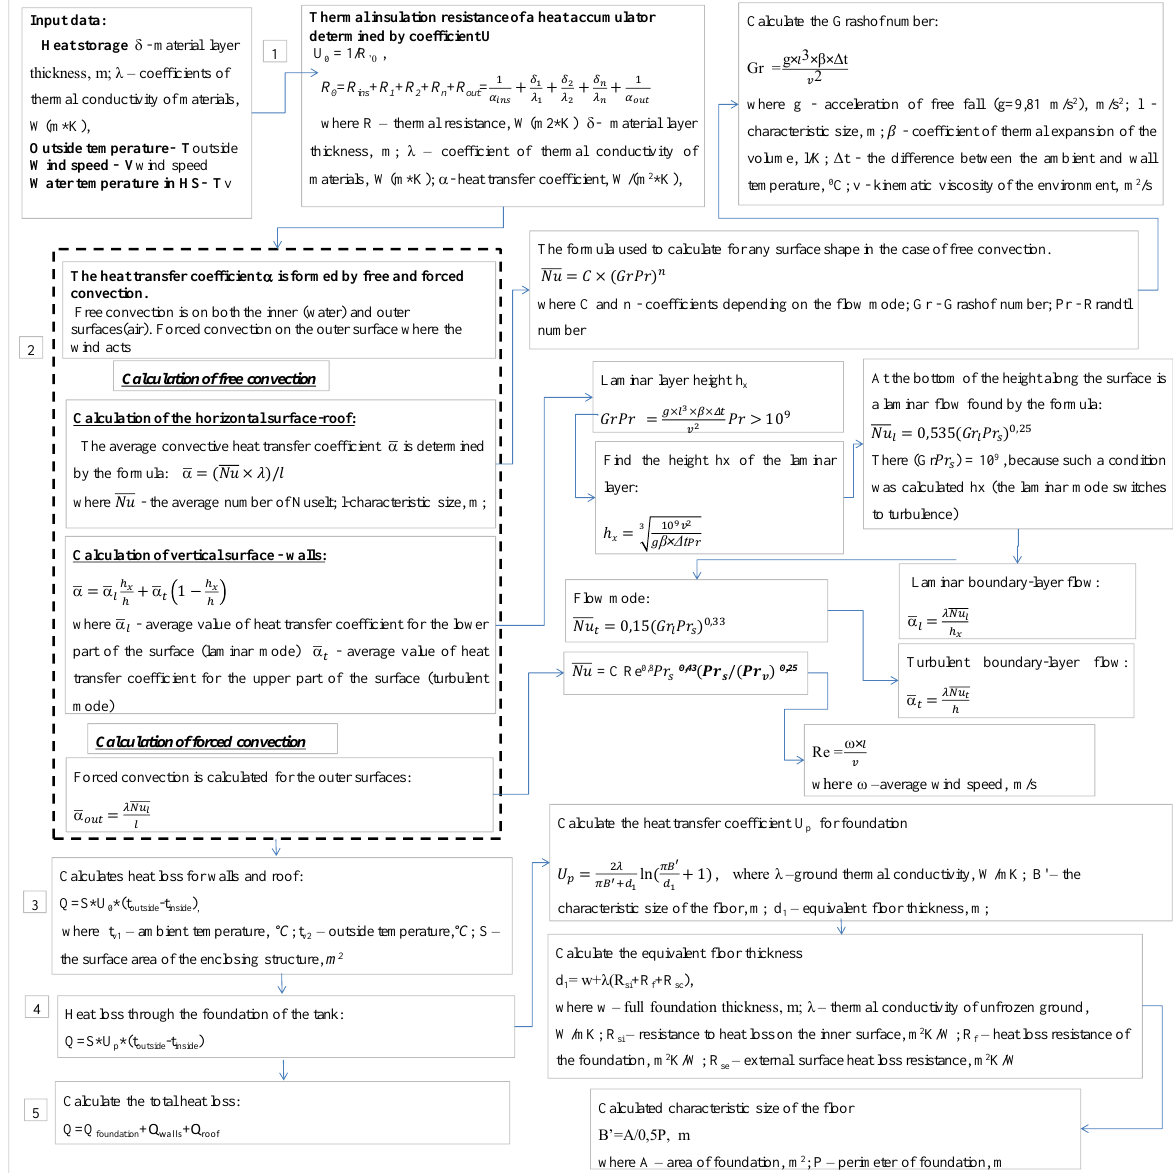
Figure 3. Heat loss calculation methodology [22] –